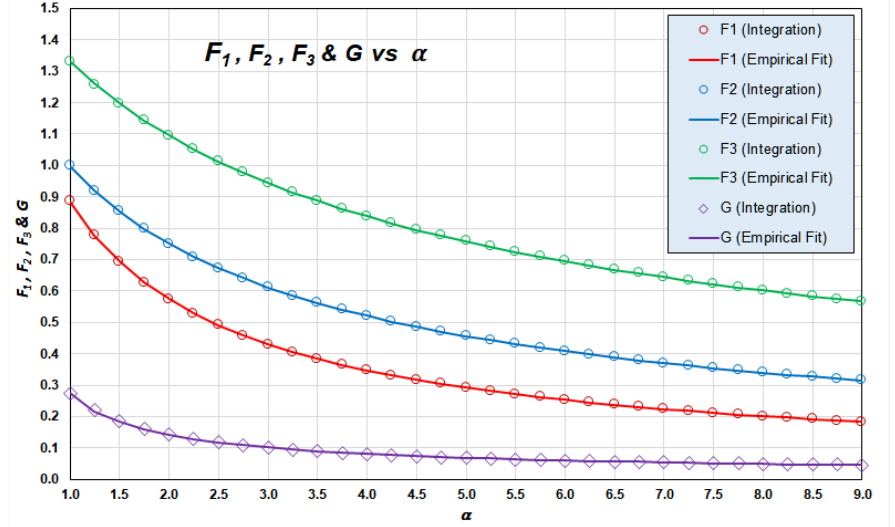
Figure 4. F 1 (α) , F 2 (α) , F 3 ( α ) and G(α) as functions of α: Numerical Integration vs. Empirical Figure 4. F 1 ( α ) , F 2 ( α ) , F 3 ( α ) and G ( α ) as functions of α : Numerical Integration vs. Empirical Formulas.